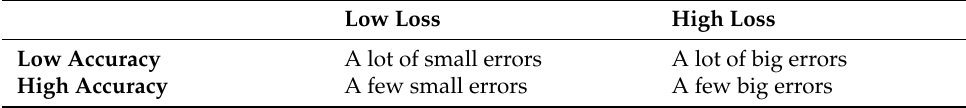
Table 3. Analysis of both loss and accuracy metrics together.